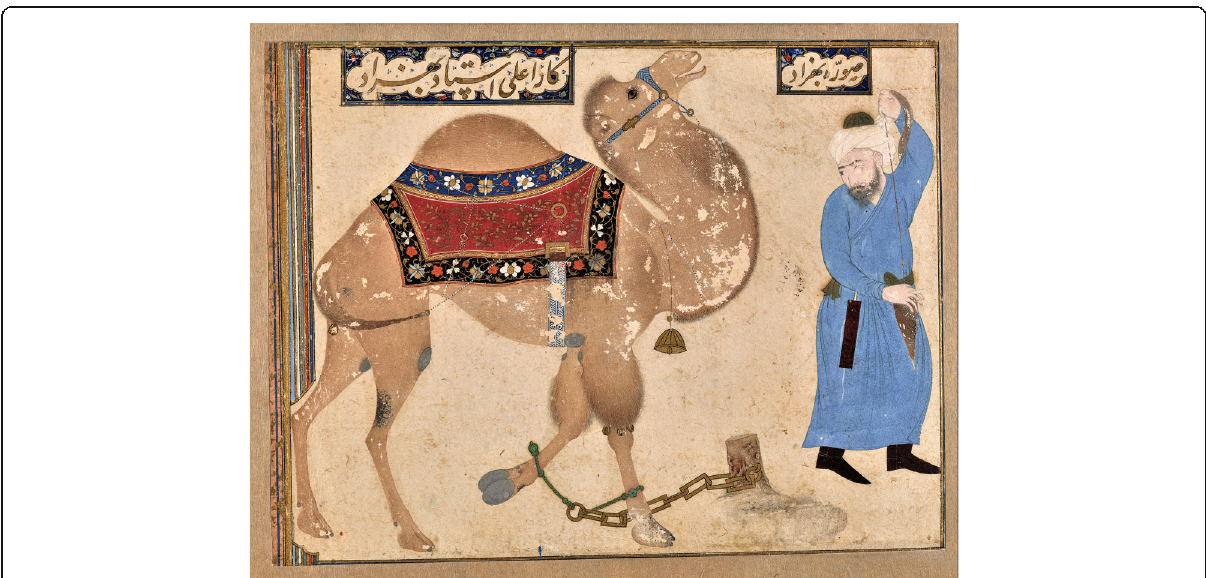
Fig. 2 Fettered camel and keeper, ascribed to Bizhad, late fifteenth century, Afghanistan, Herat, courtesy of the Freer Gallery of Art and Arthur M. Sackler Gallery-Smithsonian.